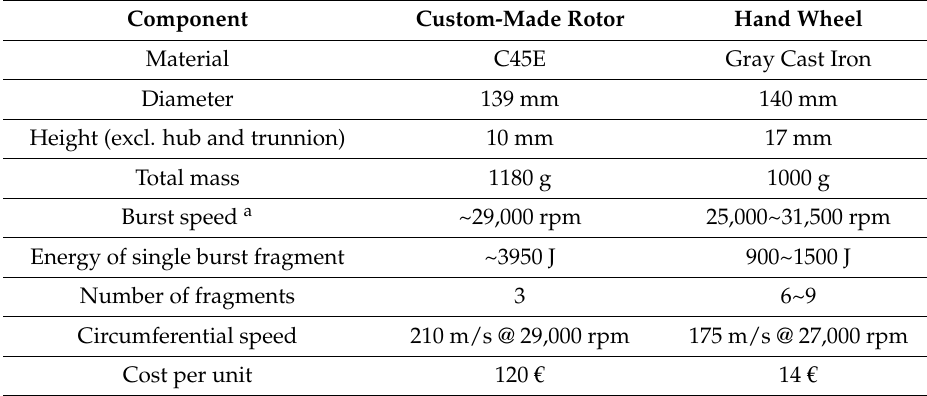
Table 5. Comparison of properties—Custom-made mill-turned rotor vs. off-the-shelf cast iron hand wheel.